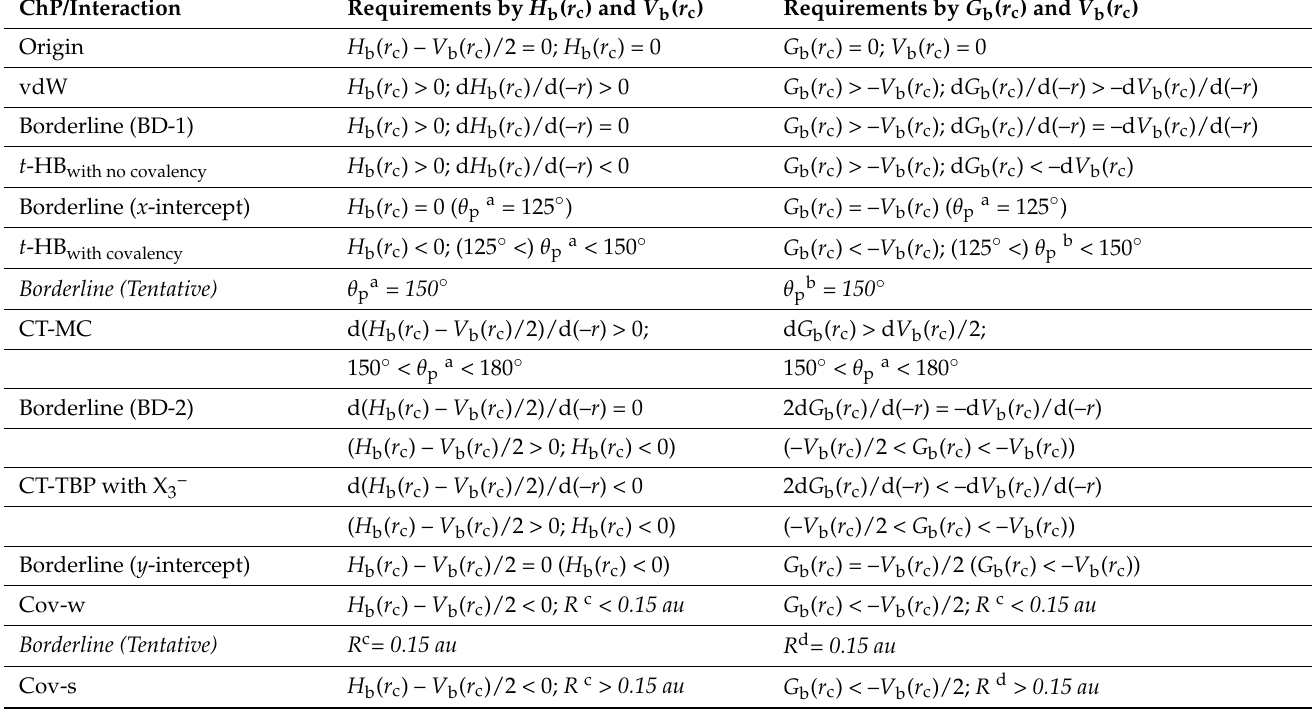
Table A1. Proposed definitions for the classification and characterization of interactions by the signs H b ( r c ) and H b ( r c ) – V b ( r c )/2 and their first derivatives, together with the tentatively proposed definitions by the characteristic points on the plots of H b ( r c ) versus H b ( r c ) – V b ( r c )/2. The tentatively proposed definitions are shown by italic. The requirements for the interactions are also